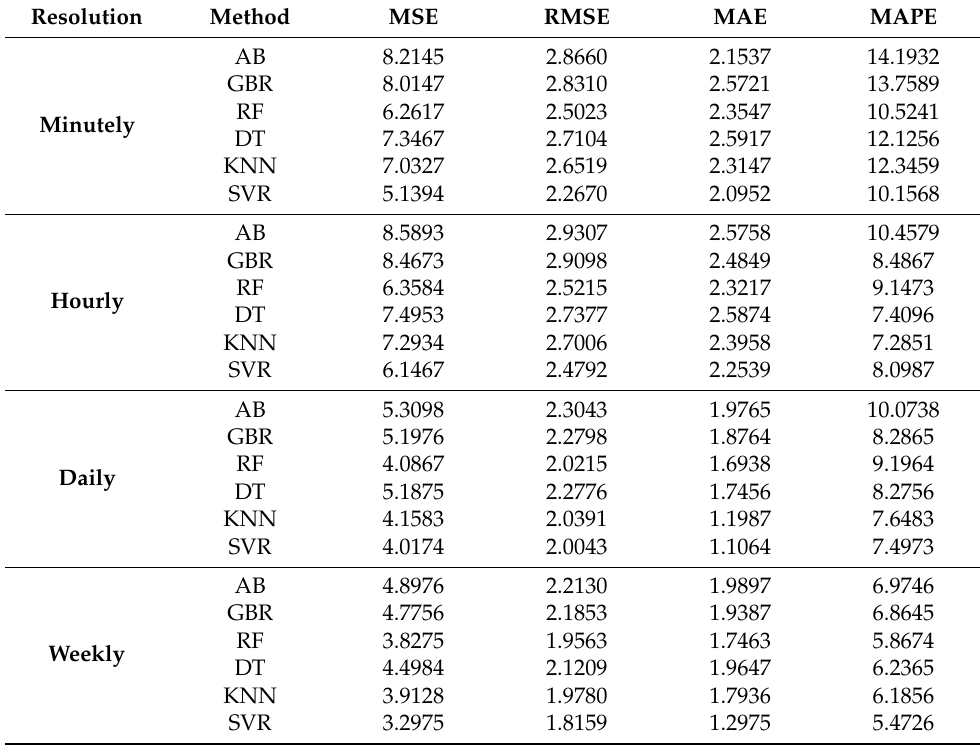
Table 8. Results obtained using ELA on different horizons using hold-out